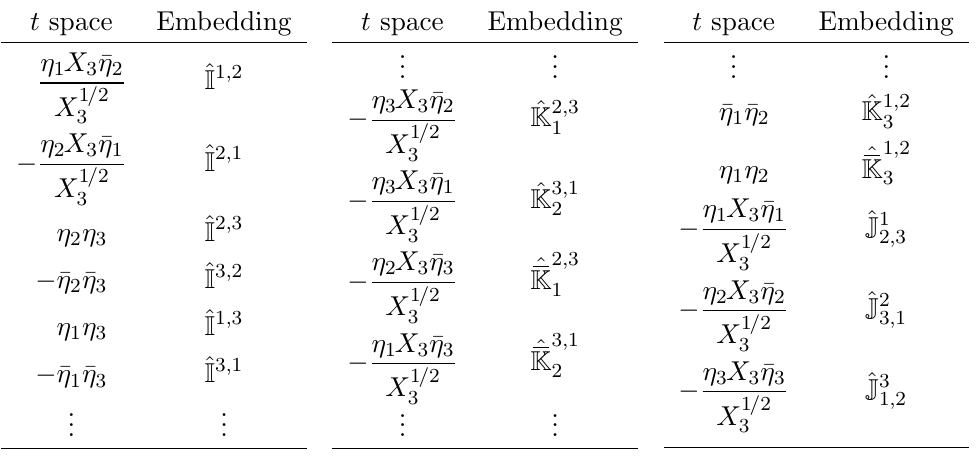
Table 2 . Mapping between the (cid:2) ; (cid:2) ! 0 limit of the non nilpotent three-point tensor structures in t space and the embedding formalism structures in [58]. The equality between neighboring columns holds after we apply the appropriate K O X a prefactor to the t space structures and the kinematic 3 1 O 2 prefactor to the embedding structures. See